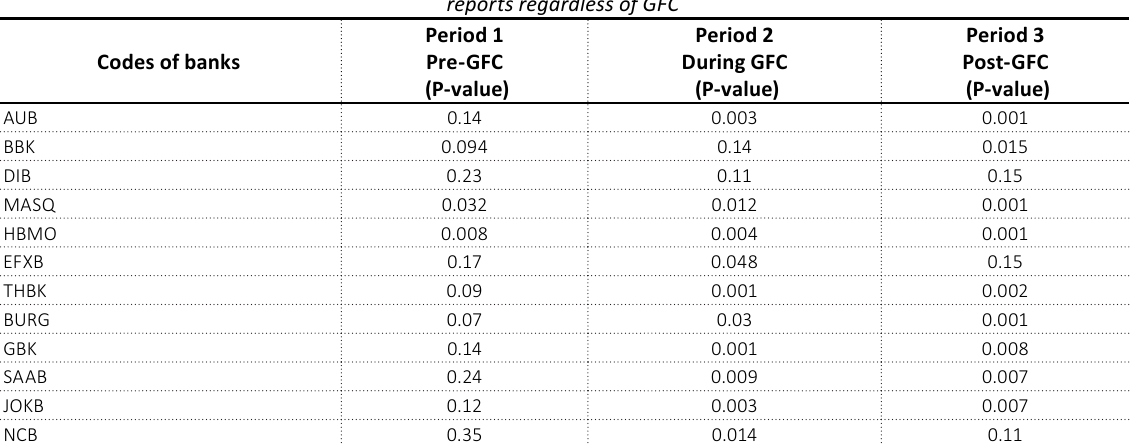
Table 7. Wilcoxon rank-sum test for the emotional words of the fear and anger categories (One Tail